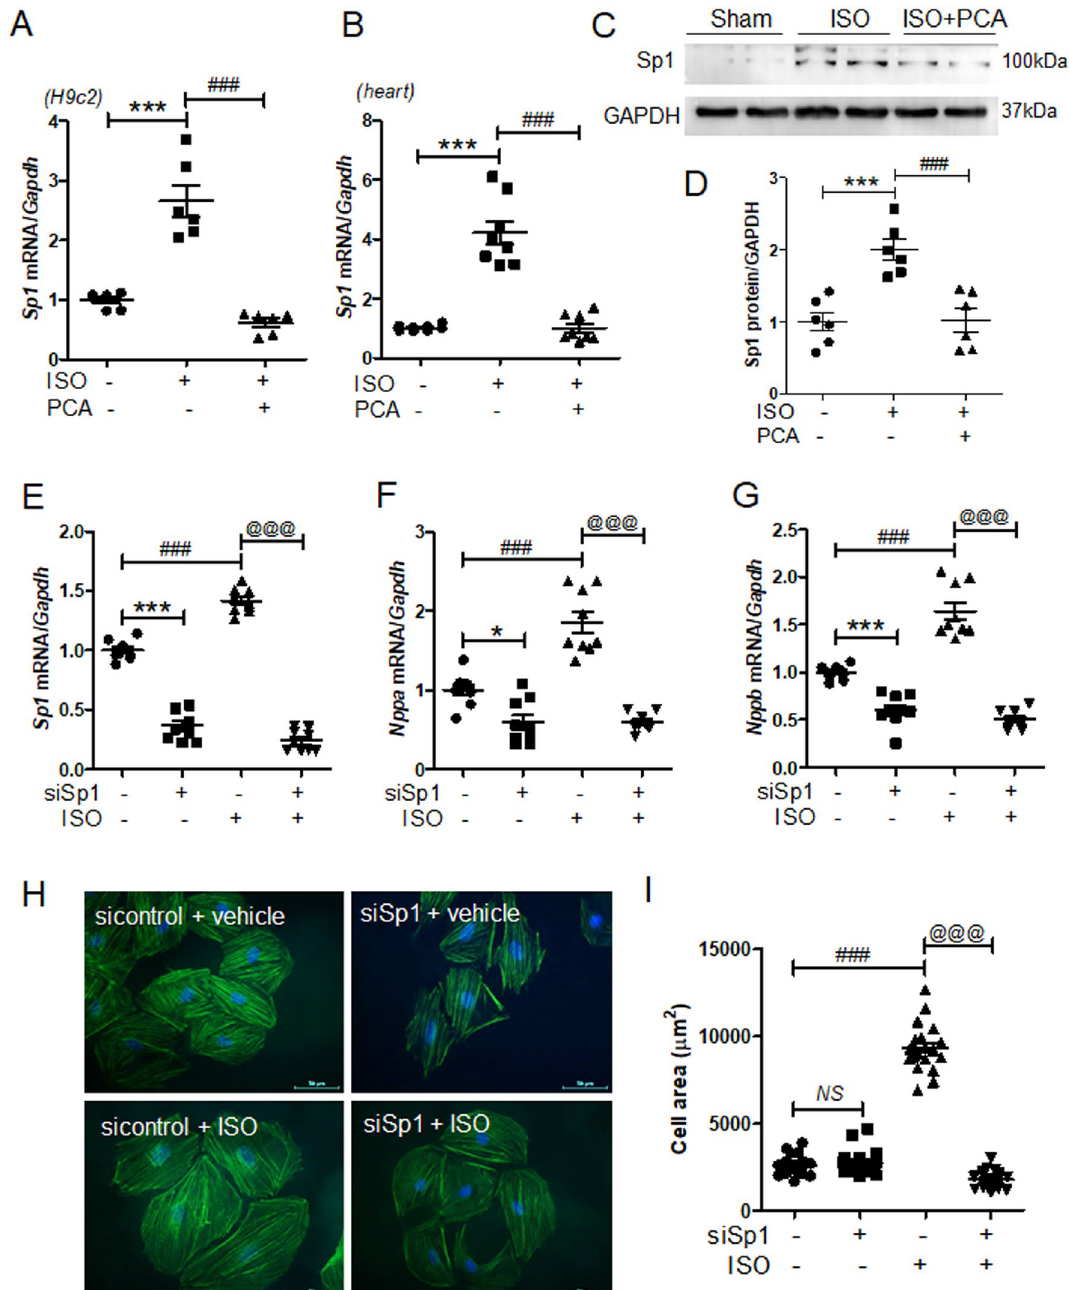
Figure 4. Sp1 knockdown reduces isoproterenol-induced cardiac hypertrophy in H9c2 cells. ( A ) Sp1 mRNA levels in H9c2 cells treated with isoproterenol (10 μM) in the presence or absence of protocatechuic acid (10 μM, n = 6). ***P < 0.001; ### P < 0.001. ( B ) Sp1 mRNA levels in heart tissues treated with protocatechuic acid (100 mg/kg/day) in the presence or absence of isoproterenol (25 mg/kg, n = 8). ***P < 0.001; ### P < 0.001. ( C ) Representative western blot images showing SP1 protein levels in mouse hearts. GAPDH was used as a loading control. ( D ) Quantification of SP1 protein levels (n = 6). ***P < 0.001; ### P < 0.001. ( E ‒ G ) H9c2 cells were transfected with control or Sp1 siRNA, serum starved overnight, and then treated with isoproterenol (10 μM). *P < 0.05 and ***P < 0.001; ### P < 0.001 ; @@@ P < 0.001. mRNA levels of Sp1 , Nppa , and Nppb (n = 9). ( H ) Merged images of H9c2 cells transfected with Sp1 siRNA, incubated with or without isoproterenol stimulation (10 μM) for 24 h, and then stained with Alexa Fluor 488 phalloidin (green) and DAPI (blue). ( I ) Cell size was quantified by measuring the cell surface area of the Alexa Fluor 488 phalloidin-stained cells (n = 20 cells). Scale bar = 50 μm. ### P < 0.001 ; @@@ P < 0.001. Data are presented as the mean ± S.E. Statistical analysis: one-way ANOVA followed by Bonferroni post hoc tests. Graphs were prepared using GraphPad